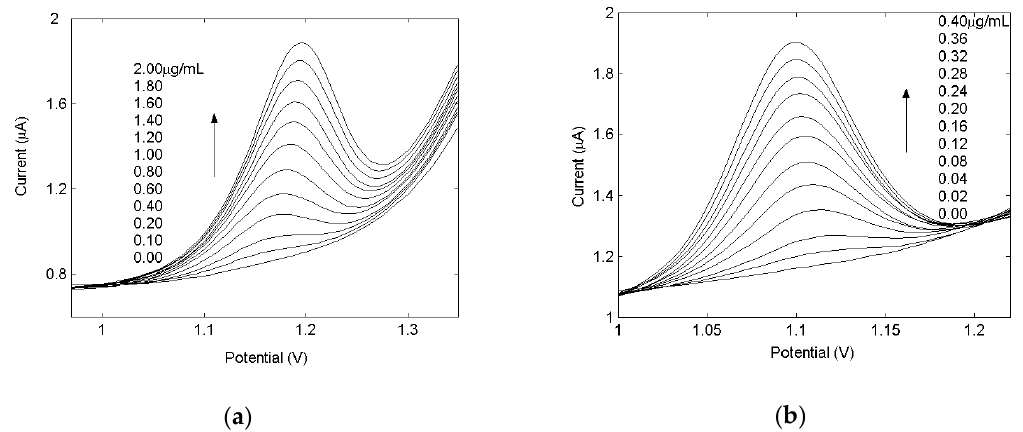
Figure 3. Voltammogram of hydrochlorothiazide ( a ) and pyridoxine ( b ) for different concentrations. Table 1. The parameters of linear equation obtained by the proposed